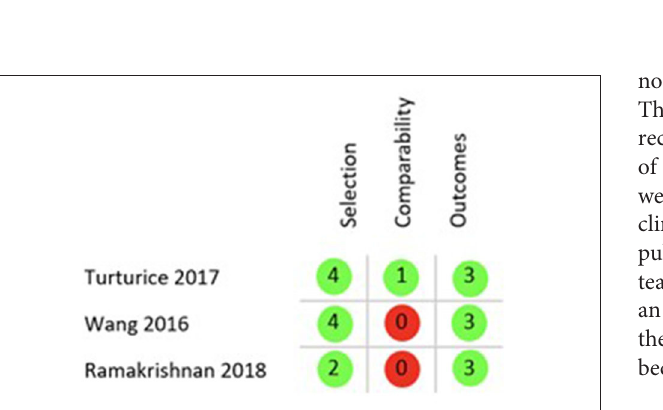
FIGURE 3 | ROB 2.0 results quality appraisal of RCTs. ROB 2.0 results of the two included RCTs, both with the result of some concerns in the overall bias.